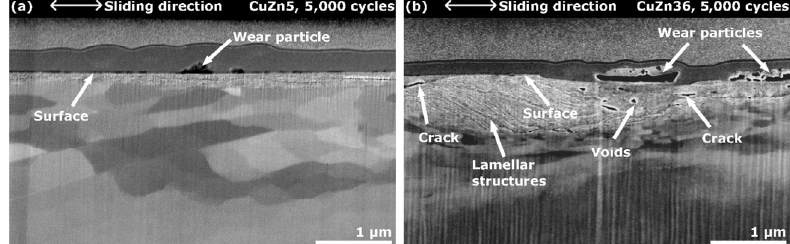
Fig. 7 Cross-sectional SEM images of the sub-surface microstructure. The microstructure in the late stage was investigated. (a) CuZn5 after 5,000 cycles, a wear particle is marked by a white arrow; (b) CuZn36 after 5,000 cycles. The cross-sections were prepared in the center of the wear track, along the sliding direction (shown as the white double arrow in the images). Sample surfaces are marked by white